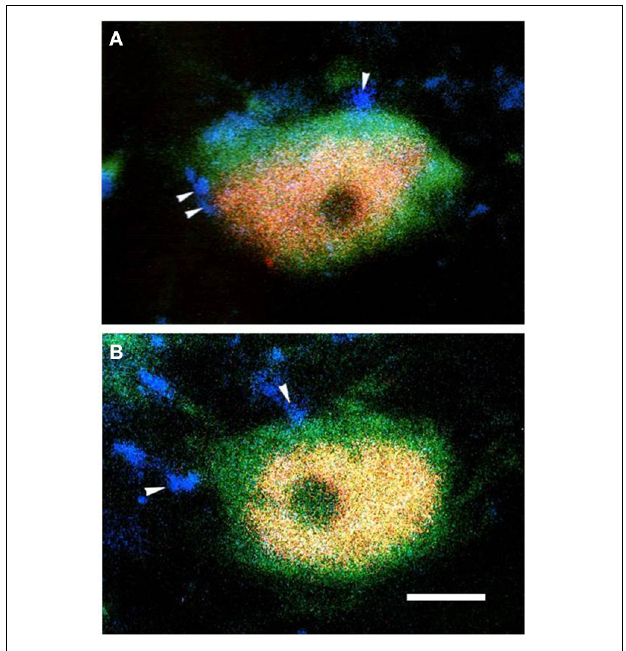
FIGURE 4 | Synaptic connections between EM2-IR axon terminals and MOR-IR and GABA-IR structures in lamina II of the Vc. EM2-IR pre-synaptic axon terminals (A , B ; EM2; filled with DAB reaction products) made asymmetric synapses with a post-synaptic MOR-IR (A) or GABA-IR (B) dendritic process, both of which were labeled with immune-gold particles. Arrowheads indicate post-synaptic membranes. Scale bars = 300nm (A) , 400nm (in B